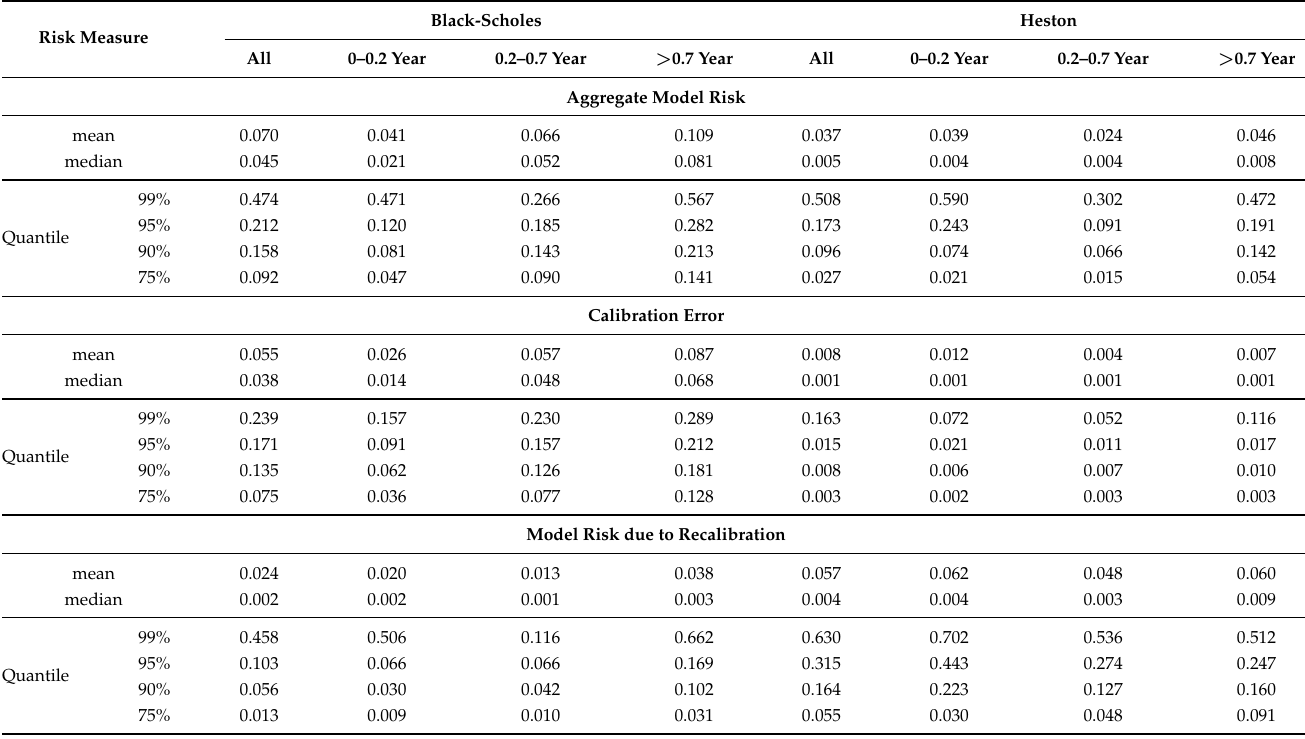
Model risks (in terms of relative entropy) under different models, by maturity buckets, for AAPL (daily recalibration